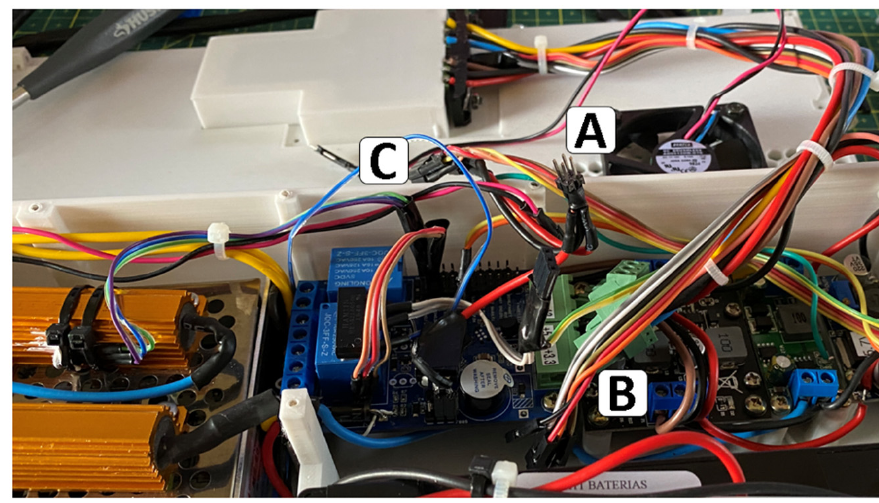
Figure 21. Battery charge test setup: A—Output of the regulator, B—sensor connectors and C— OLED and UART connectors.